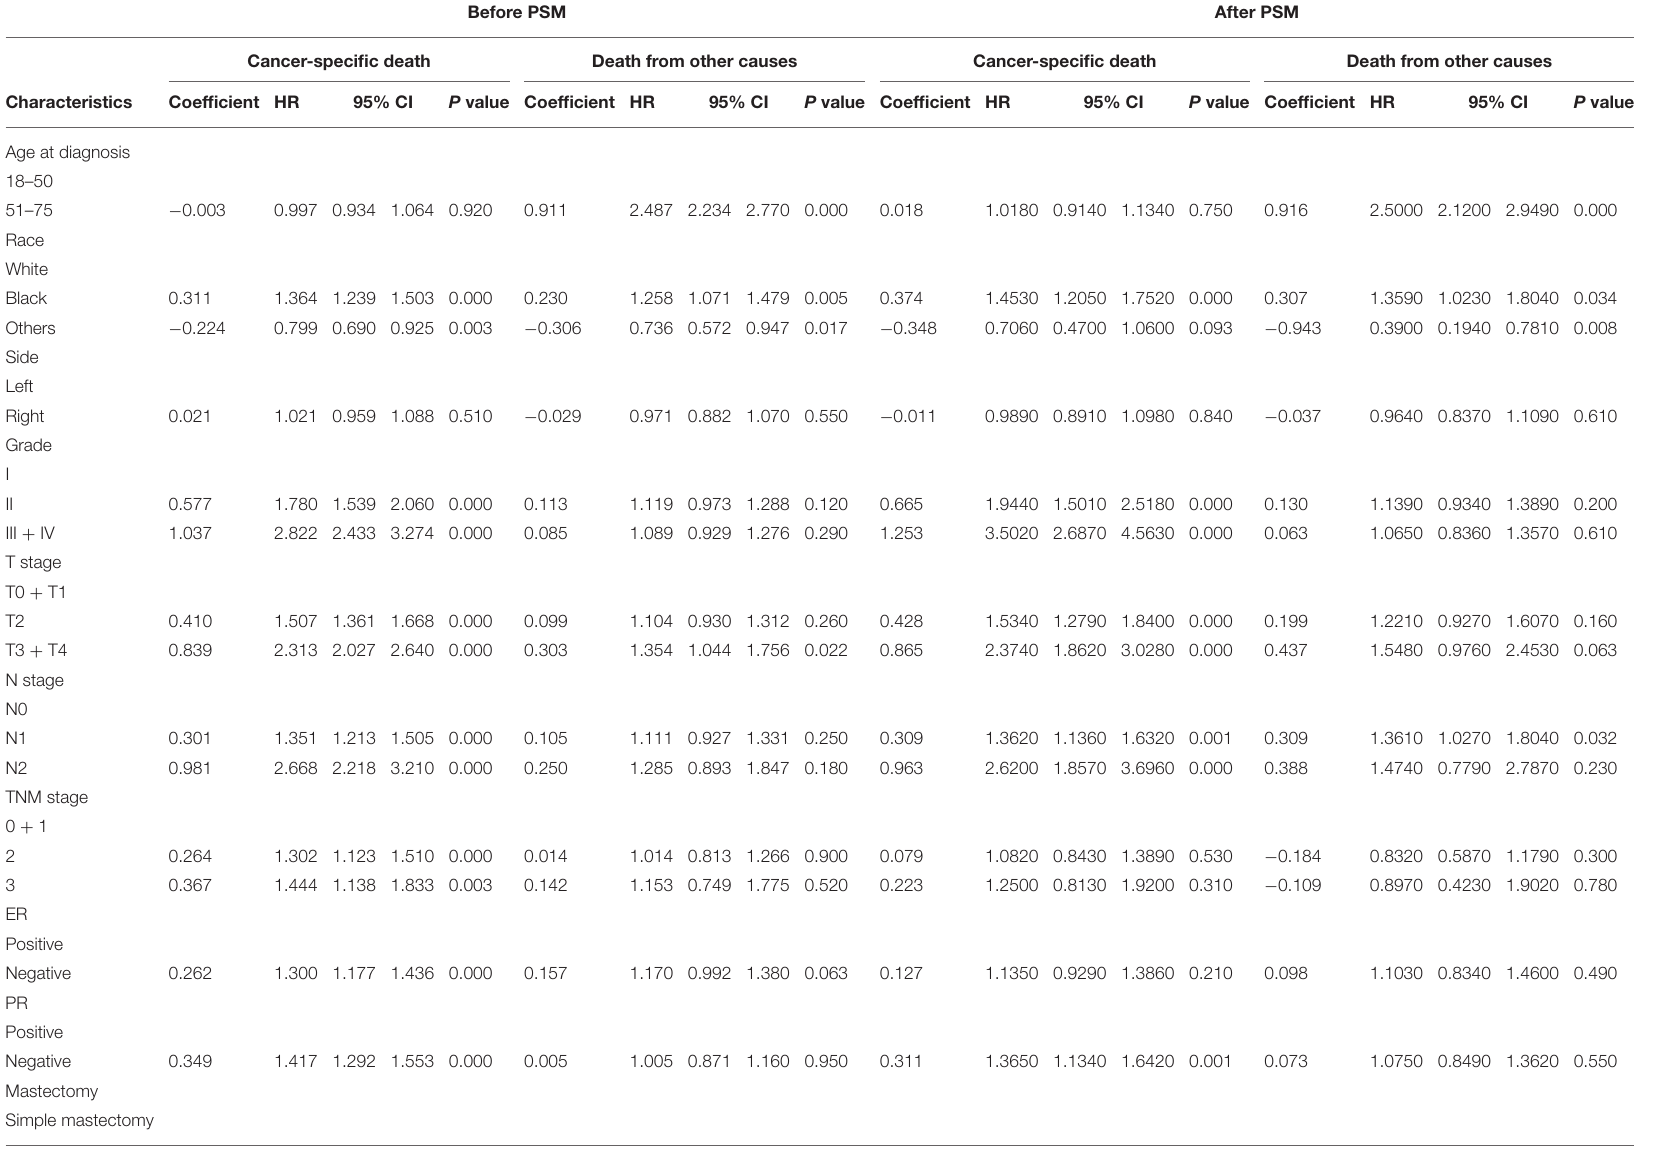
TABLE 3 | Competing risk model analysis of BCSD and